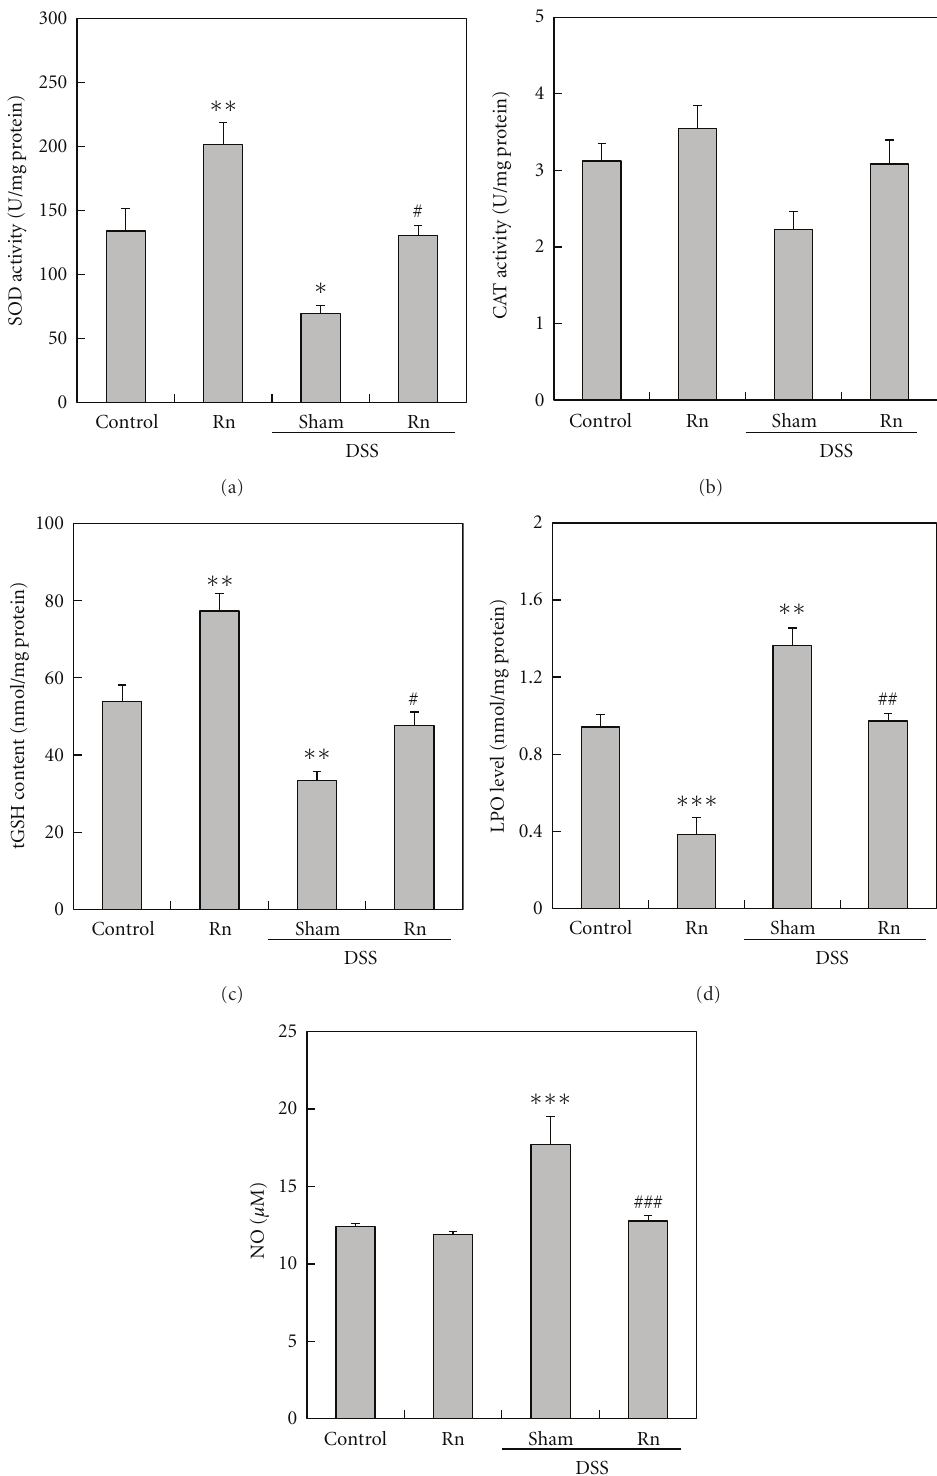
Figure 5: E ff ects of radon inhalation on antioxidant-associated substances after colitis induction. (a) SOD activity, (b) CAT activity, (c) tGSH content, and (d) LPO level in the colon and (e) NO level in plasma. Each value is the mean ± SEM. The number of mice for each experiment and significance are the same as in Figure